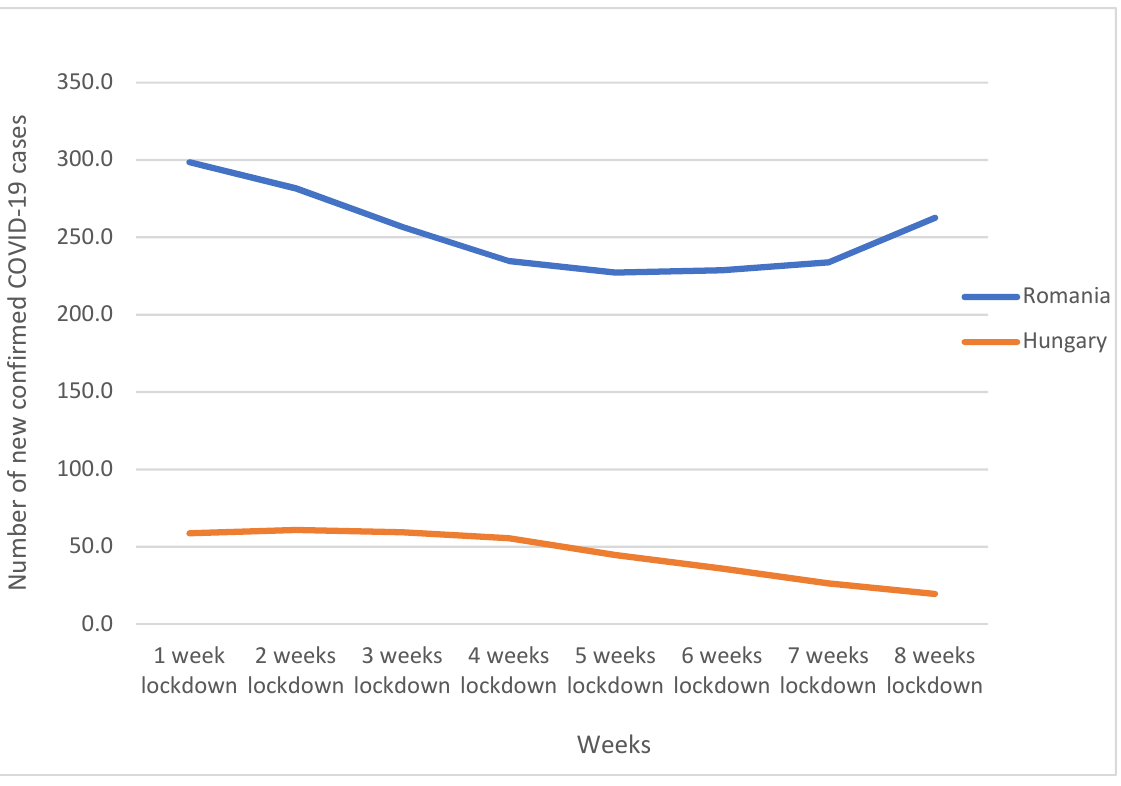
Figure 1. New confirmed COVID-19 cases.